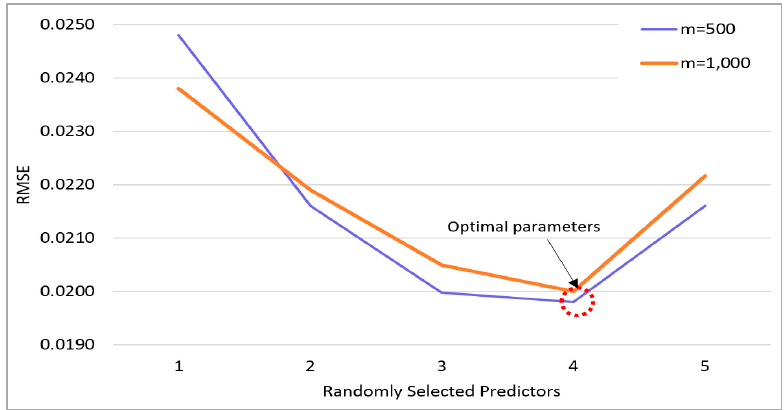
Figure 7. Selection of optimal parameters of random